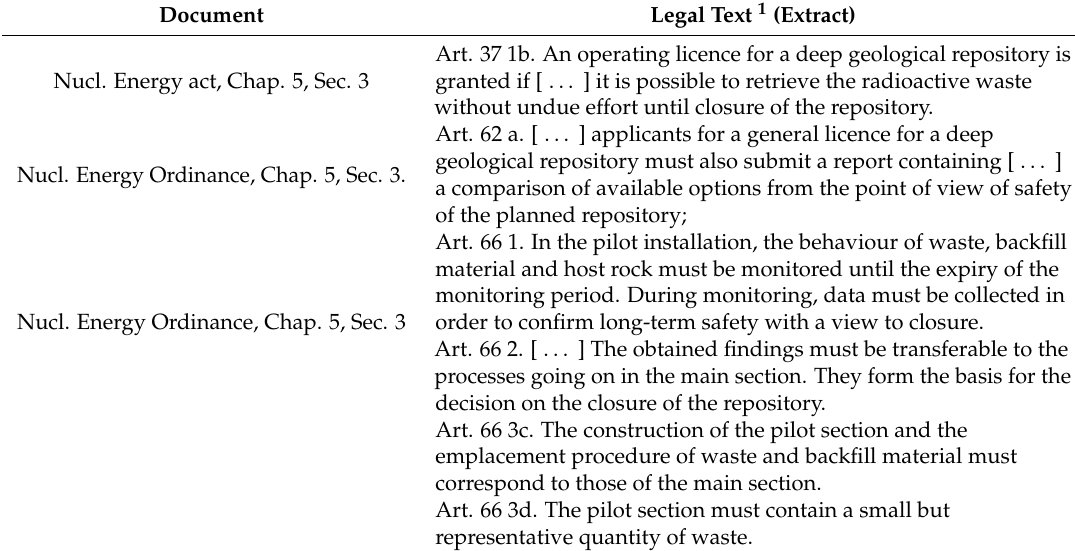
Table A1. Excerpts from the Nuclear Energy Act 732.1 of 21 March 2003 (Status as on 1 July 2016, Federal Assembly of the Swiss Confederation) and of the Nuclear Energy Ordinance 732.1 of 10 December